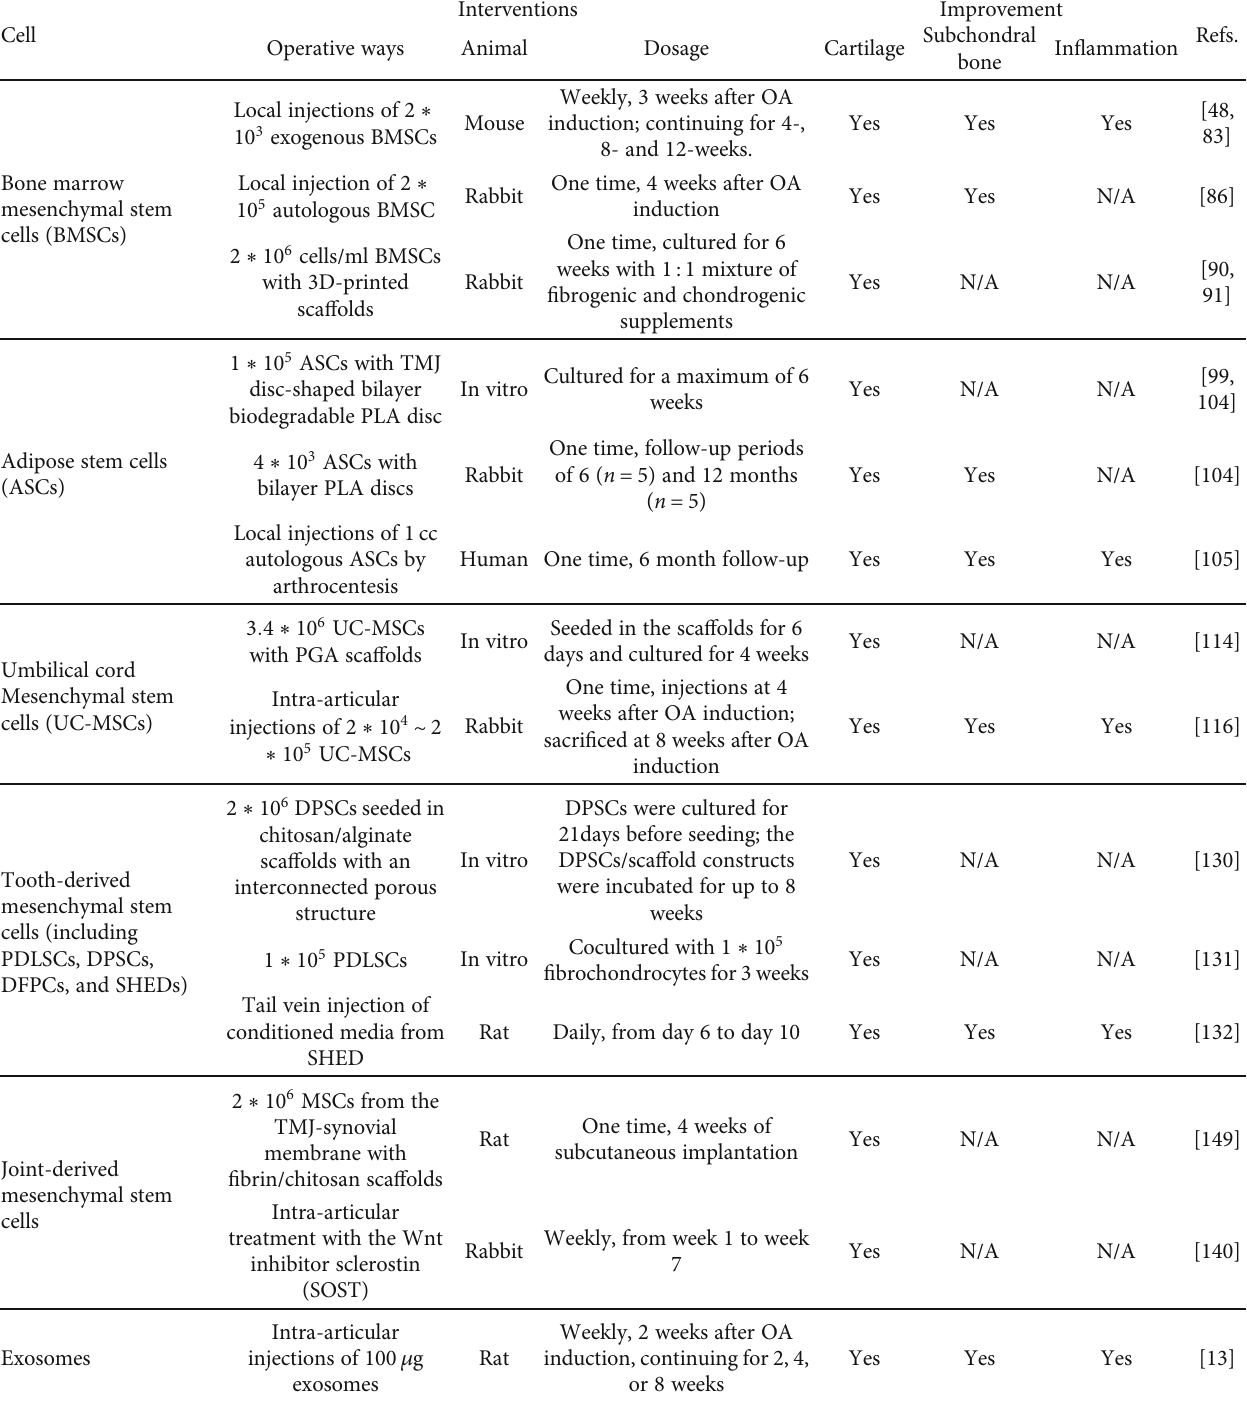
Table 1: An overview of various tissue-speci fi c MSCs utilized in osteoarthritic TMJ or TMJ regenerative tissue engineering.